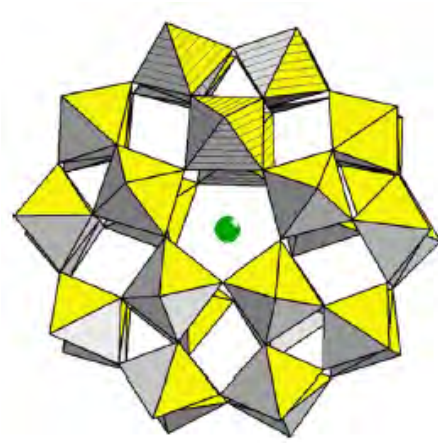
Figure 1. Preyssler